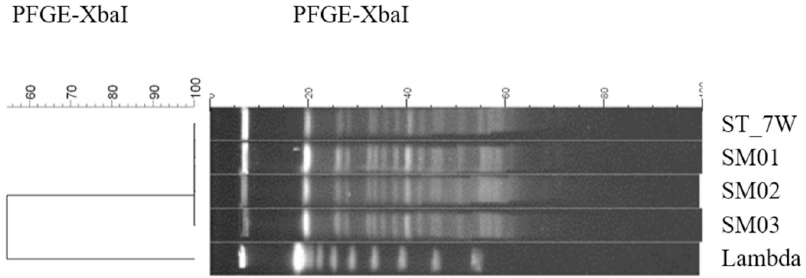
Fig 3. Result of pulsed field gel electrophoresis and dendrogram of carbapenemase-producing K . pneumoniae . Percentage similarities are shown above the dendrogram. ST_7W, K . pneumoniae from the stethoscope; SM 01 to 03, K . pneumoniae isolates form the patients. PFGE, Pulsed-field gel electrophoresis.